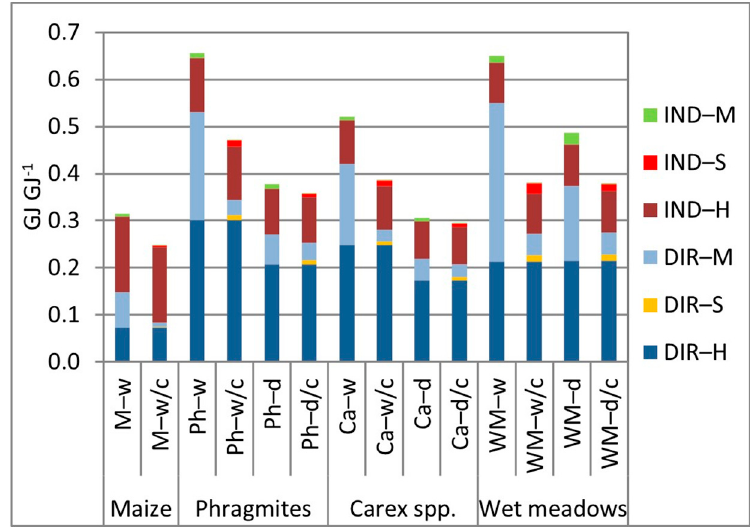
Figure 6. Energy efficiency of various feedstocks; w—wet fermentation, d—dry fermentation, c—separation and composting of digestate; DIR—direct energy input from fuel, IND—indirect energy input; H—cultivation and harvest, S—separation of digestate and composting of a solid phase, M—management of digestate/compost.